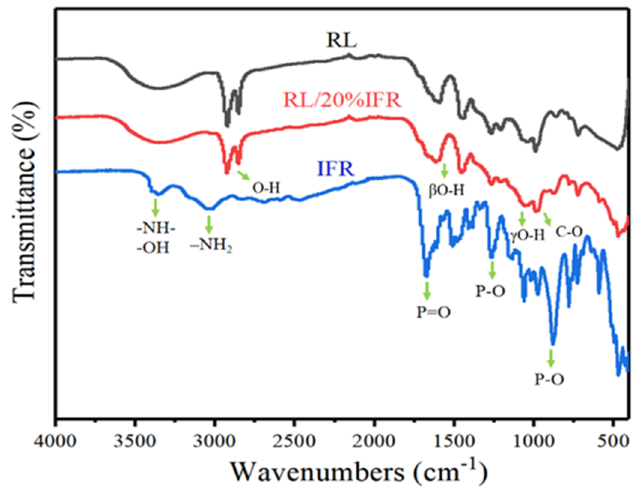
Figure 2. FT-IR of raw lacquer and RL/IFR as related to different proportions. As for RL’s spectra, the absorption peaks of urushiol’s C-O-H group occur at 3439, 1363, 1275, and 1150 cm − 1 , which correspond to the stretch vibration of O-H, β O-H, γ O- H, and C-O, respectively [13,21,22]. Comparing FT-IR spectra of RL and RL/IFR, it is